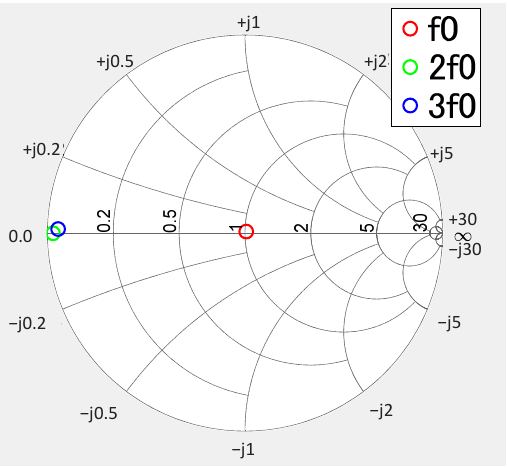
Figure 3. Impedance of the proposed patch antenna at fundamental (f0) and second (2f0)- and third (3f0)-harmonic frequencies (simulation).